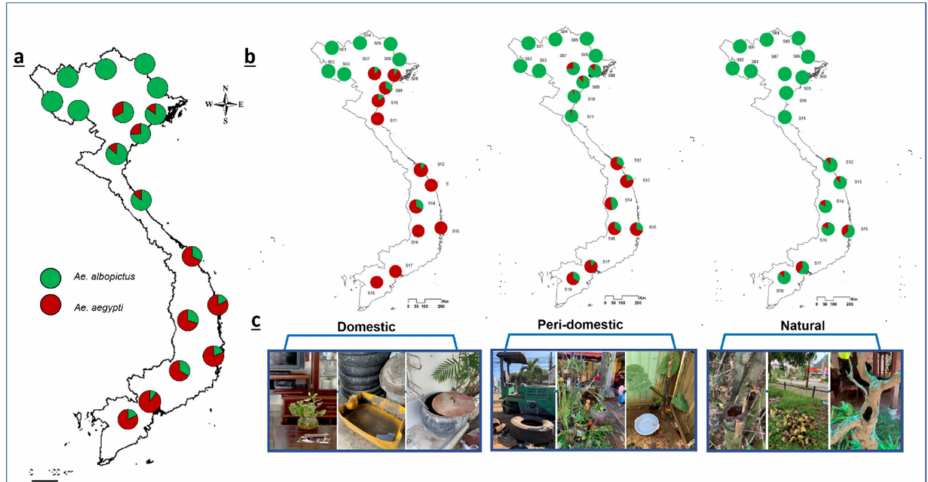
Figure 2. Relative abundance of Aedes species within study sites in Vietnam. ( a ) Relative abundance of Ae. aegypti and Ae. albopictus across all habitat types. ( b ) Relative abundance of Ae. aegypti and Ae. albopictus within specific habitat types (domestic, peri-domestic, and natural). ( c ) Examples of containers found in each habitat